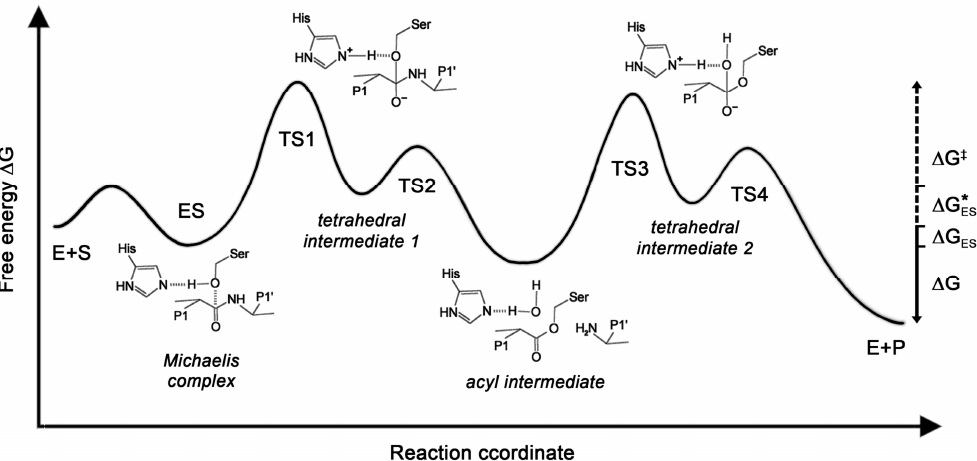
Figure 4. Free energy profile for substrate turnover by the serine protease trypsin [118,144,148]. Various approaches find shifted energy levels and additional energy minima of intermediates and the enzyme product complex [149,150]. The y-axis represents the Gibb´s free energy of the process ( ∆ G ), which is temperature dependent and related to the reaction enthalpy and entropy: ∆ G = ∆ H − T ∆ S . The reaction coordinate represents the progress of the reaction, not a real time process. E, S, and P denote enzyme, substrate and products, while TS1 to TS4 are transition states. Direct conversion of k cat and K M into free energy values is not feasible, while they show an inverse correlation, e.g., a high k cat with a lower free activation energy ∆ G ‡ . Currently, the influence of glycosylation on the single mechanistic steps can only be estimated, but differences in the binding energy of the transition states can be calculated as for mutant enzymes [151]. For the substrate Bz-Pro-Phe-Arg-pNA with the k cat / K M values of N -glycosylated KLK2 (76,930 M − 1 ·s − 1 ) and of glycan-free KLK2 (5780 M − 1 ·s − 1 ) with ∆ G = − RT ·ln([ k cat / K M ] glyc /[ k cat / K M ]) the result is − 6.7 KJ·mol − 1 [140].